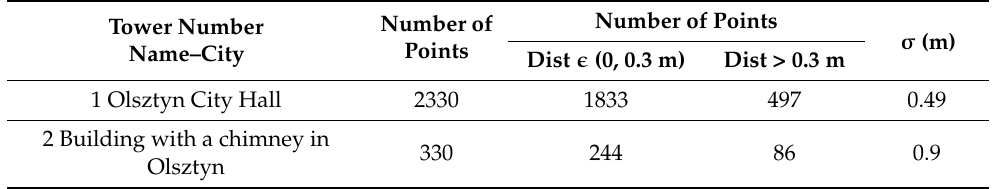
Table 1. Standard deviations and the number of points that deviate from the tower model within the specified